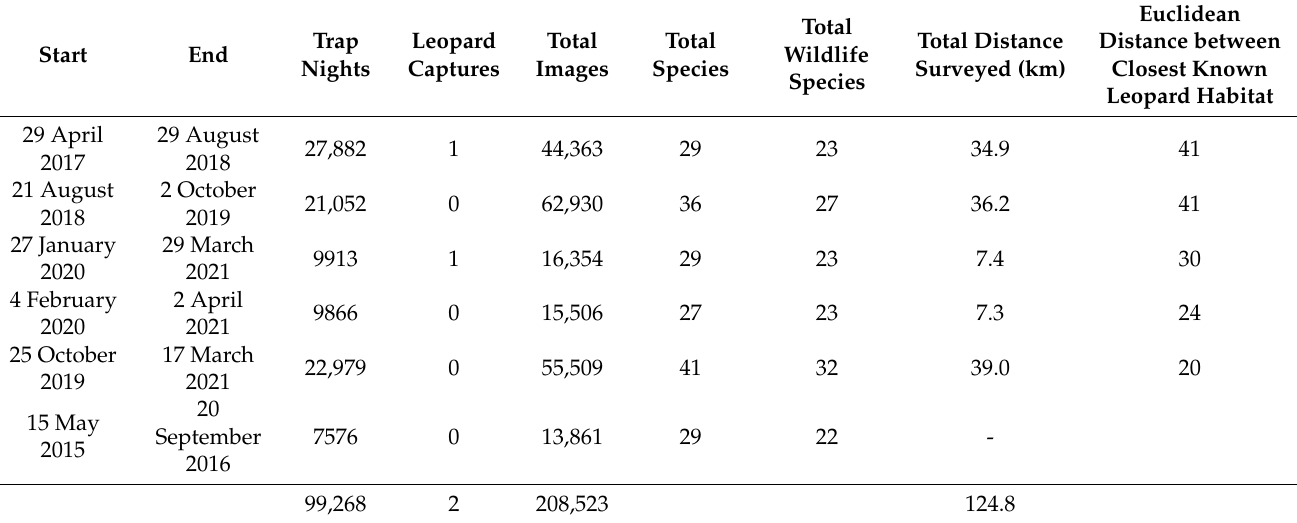
Table 3. Summary of the camera trap survey to assess corridor